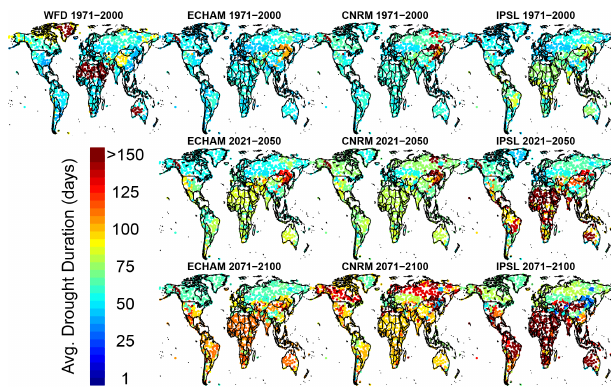
Figure 4. Spatial distribution of average hydrological drought du- ration for different time periods, obtained from simulations of the conceptual hydrological model, using meteorological forcing by the WATCH Forcing Data (WFD) and three GCMs: ECHAM, CNRM and IPSL.